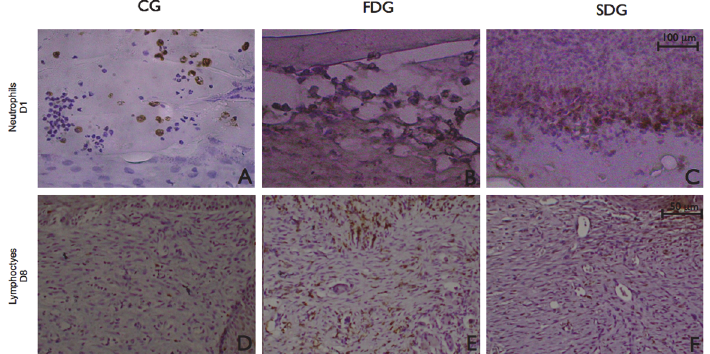
Fig 3. Histological examination of healing tissue — Day 3: all groups in inflammatory phase of tissue repair (A, B, C), with a crust over the ulcer and an intense inflammatory infiltrate ( * ); Day 8: wounds in proliferative phase with granulation tissue (D, E, F); Some samples in FDG exhibited acute inflammatory infiltrate at this time ( * ). hematoxilyn & eosin staining; original magnification: 200 x